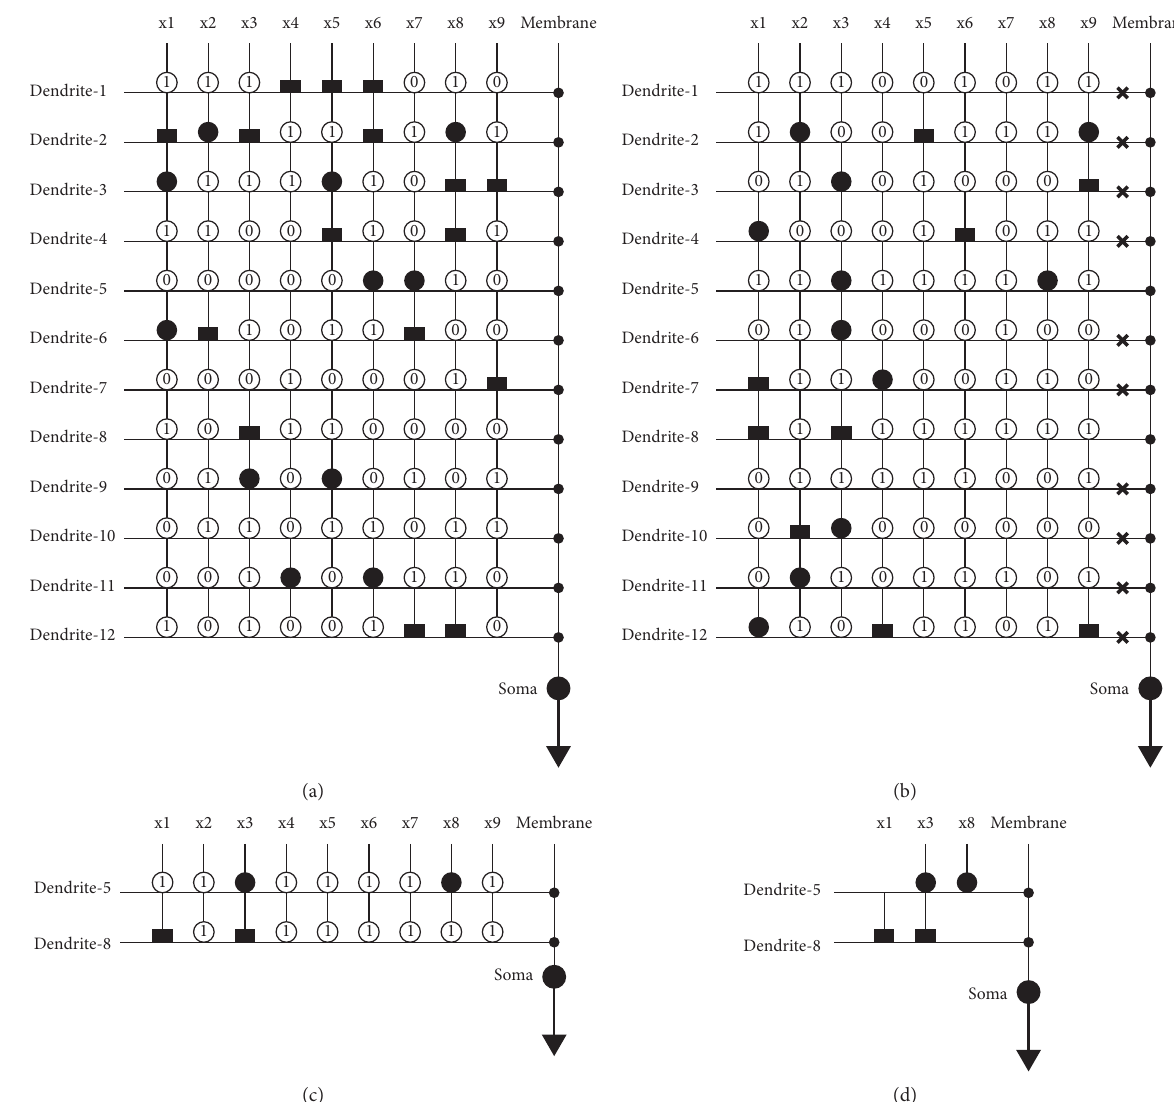
Figure 8: Evolution of neuronal morphology on GID problem.